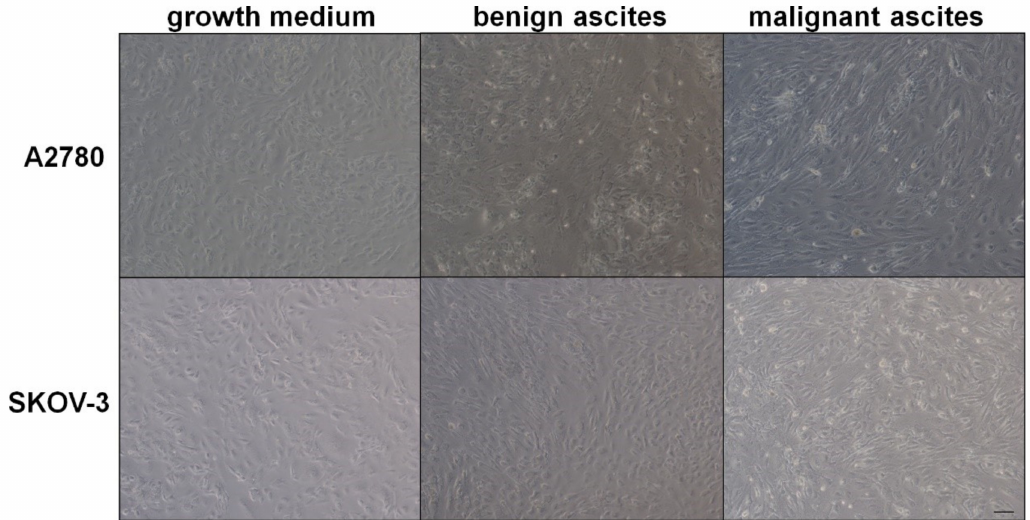
Figure 2. Representative pictures showing the development of the spindle-shaped morphology typical for cells undergoing epithelial-mesenchymal transition (EMT) in ovarian cancer cells subjected to malignant ascites (magnification × 50; bar 100 µ